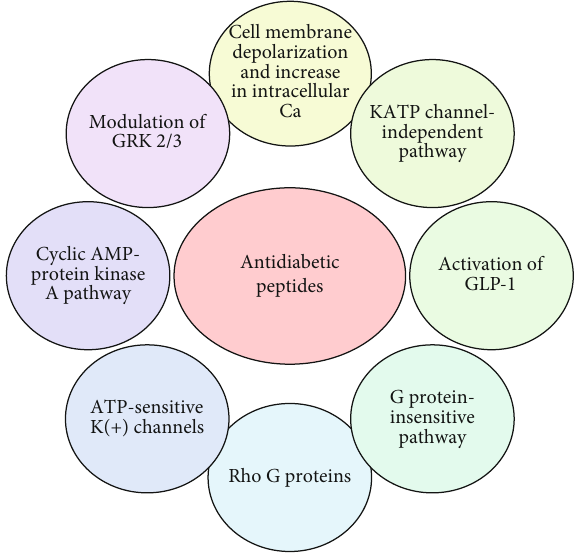
Figure 1: Proposed mechanisms of action for antidiabetic